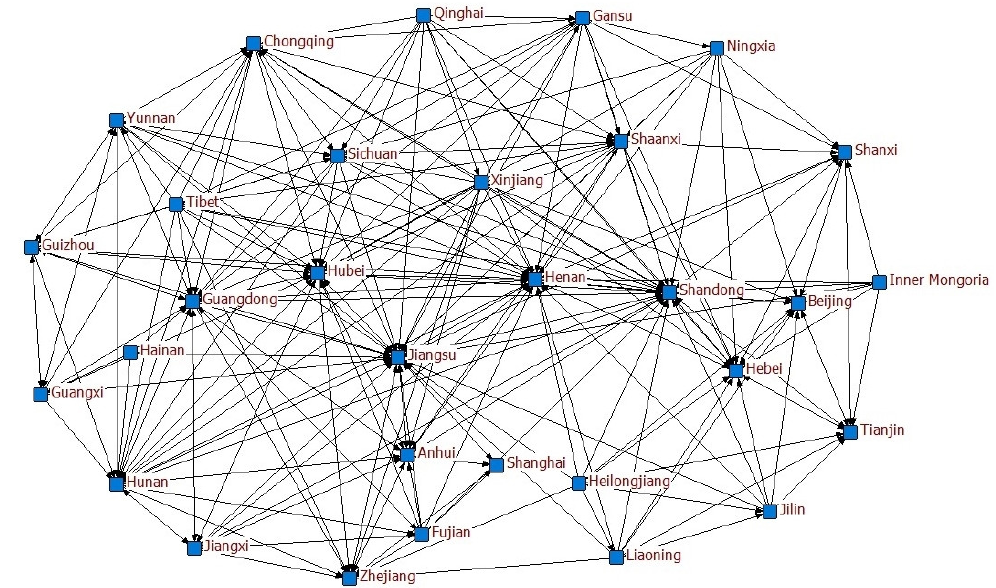
Figure 1. Spatial association network of PM 2.5 in China in 2020.